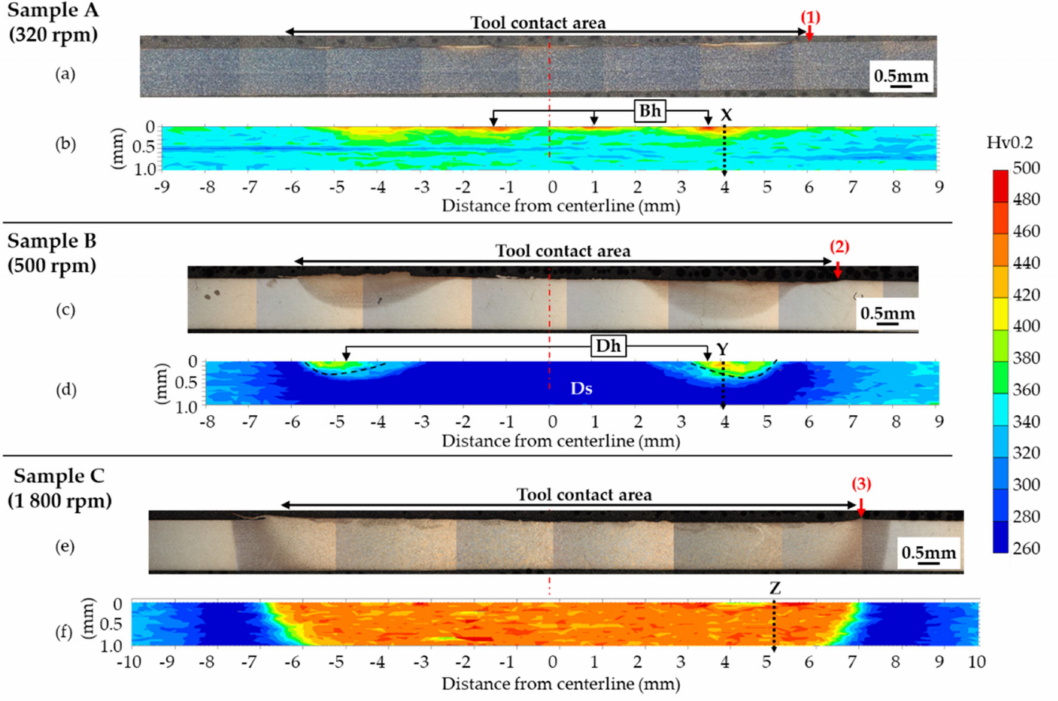
Figure 4. Cross-sectional optical microscopy (OM) image of macrostructures and a mapping of Vickers microhardness distribution: ( a ), ( b ), ( c ), ( d ), and ( e ), ( f ) are OM images and hardness distributions of sample A, B, and C, respectively. The tool edge for each sample was marked as “1,” “2,” and “3.” Location “Bh” and “Dh” in sample A and sample B, respectively, were the hardened areas. Location “Ds” was the softened area in sample B. Dashed line “X,” “Y,” and “Z” were selected for detailed characterization in the following